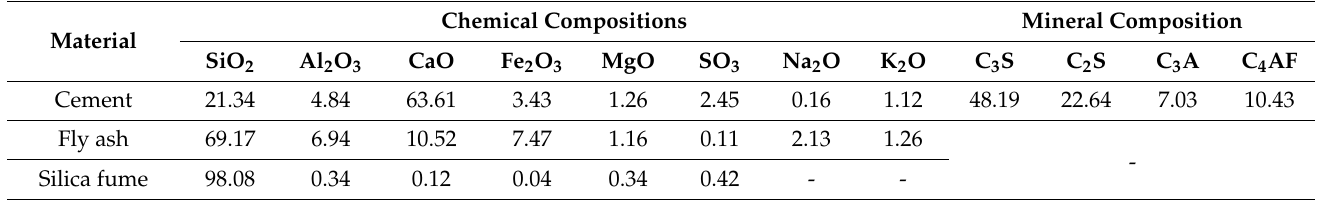
Table 1. The chemical compositions of cementing material (wt %).